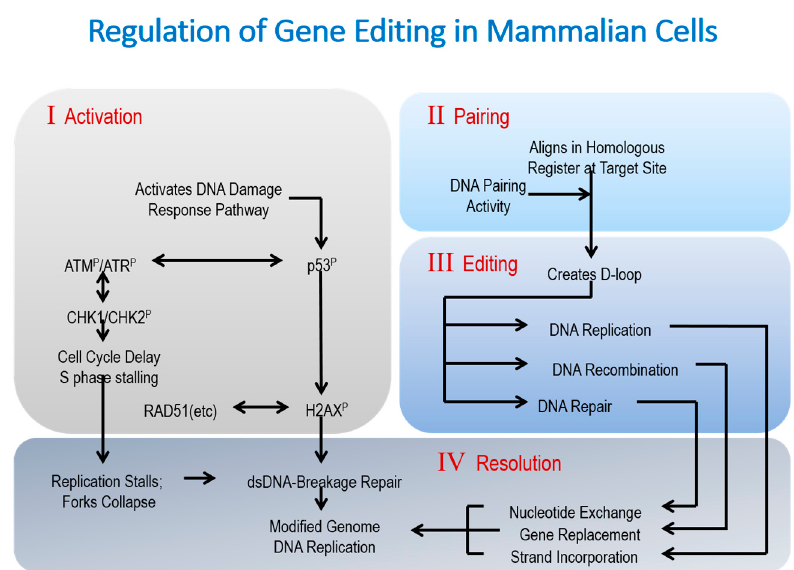
Figure 2. Regulation of gene editing in mammalian cells. In this diagram, traditional pairing and repairing (or resolution) phases of gene editing are expanded to include specific reactions that take place before, during, and after nucleotide exchange. Importantly, a whole series of metabolic events including DNA replication and DNA repair are active.